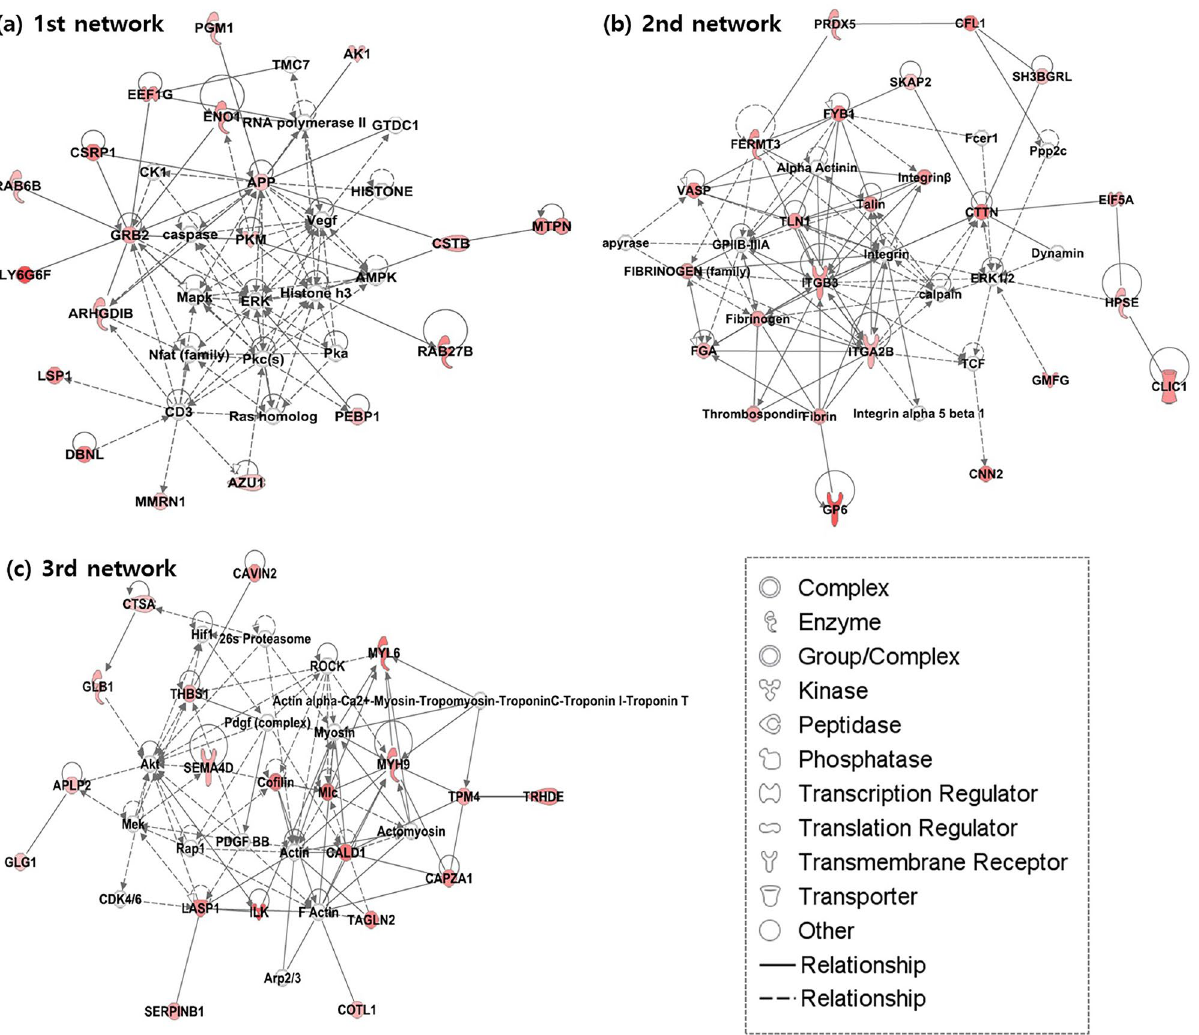
Figure 3. Top three interaction networks generated by ingenuity pathway analysis (IPA) software (data version 76765844) are displayed, respectively, in ( a )–( c ). Proteins showing statistically significant increases (P-value < 0.05, > 2.0-fold) in psoriasis patients with CVD risk factors are in red. ERK, integrin/ERK1/2, and actin are, respectively, are seen as the major hubs in each network. Straight lines indicate direct interactions, whereas dashed lines indicate indirect